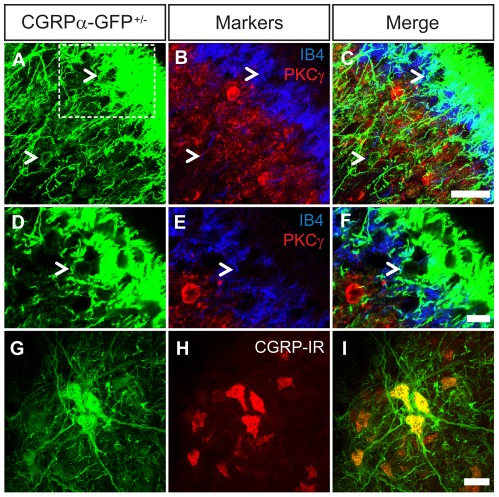
CGRPα-GFP marks a small population of neurons in lamina II/III and motor neurons in spinal cord.Sections of lumbar spinal cord from CGRPα-GFP+/− mice were stained with (A–F) antibodies to GFP (green) and PKCγ (red). IB4-binding (blue). Arrowheads point to GFP+ cells. (D–F) Single confocal scan image from box in (A) reveals a CGRPα-GFP+ neuron located in lamina II. (G–I) Motor neurons stained with antibodies to GFP (green) and CGRP (red). Images were acquired by confocal microscopy and are representative of n = 3 mice. Scale bar in (C and F) is 25 µm and in (I) is 100 µm.